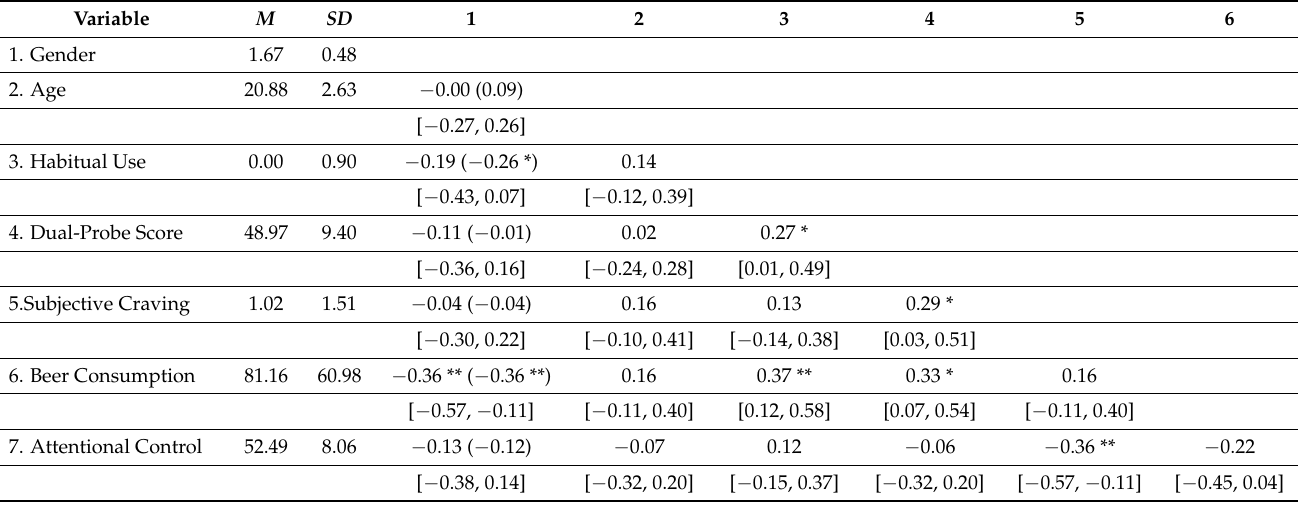
Table 2. Means, standard deviations, and correlations with confidence intervals between variables of interest. Variable